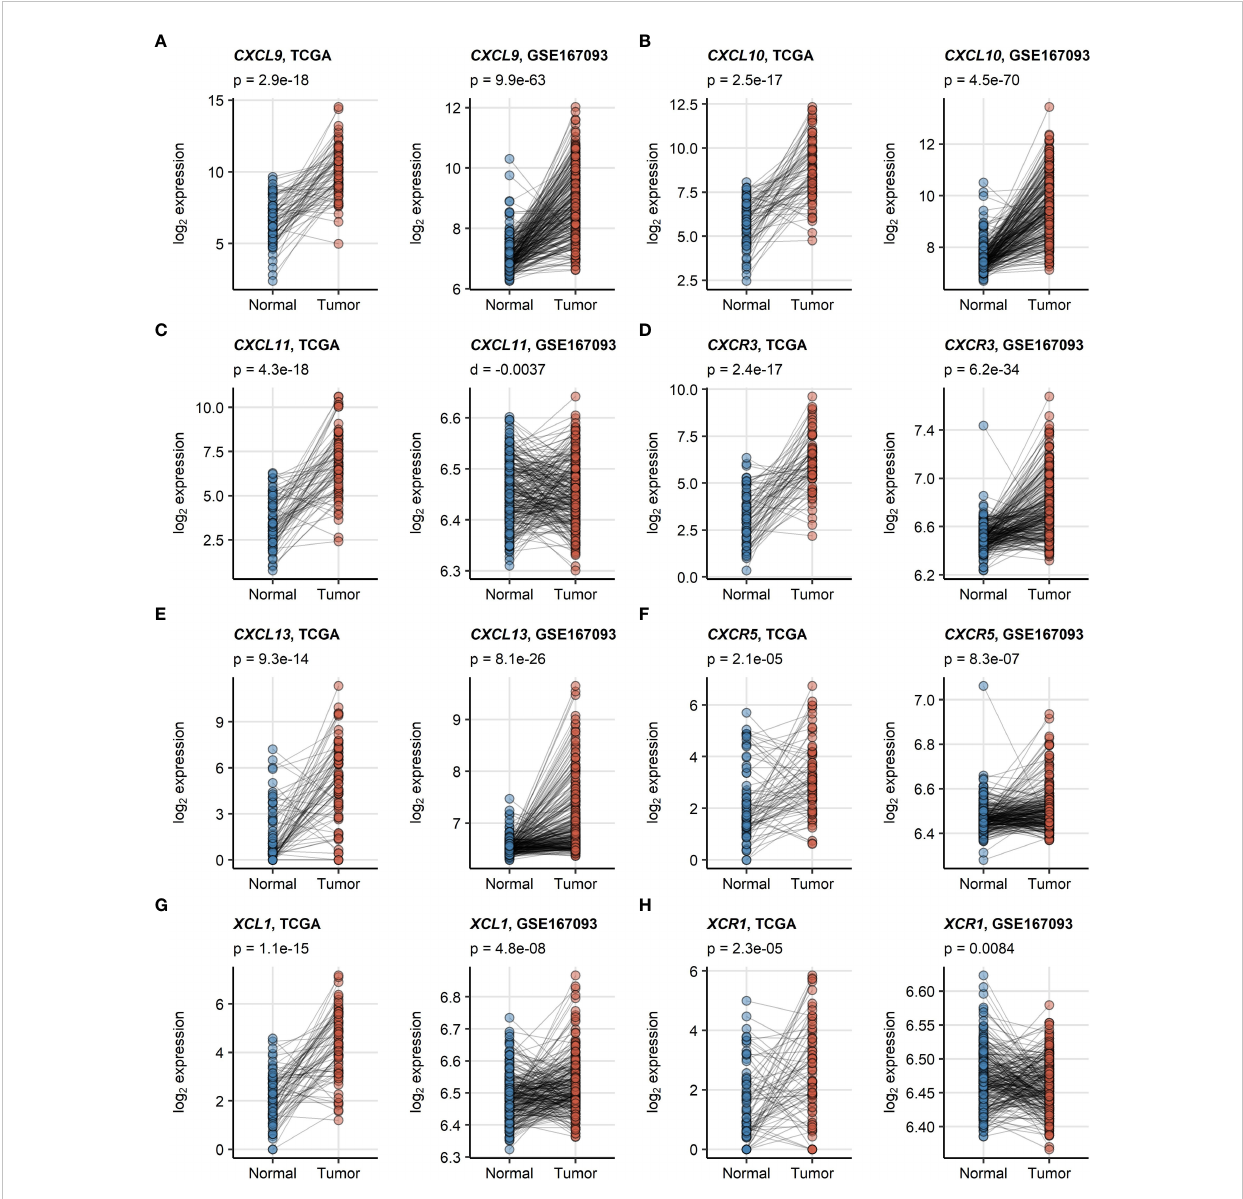
FIGURE 1 (A – H) Differences in expression of CXCL9/10/11 , CXCL13 , XCL1 and their cognate receptors between RCC and normal kidney tissue. Differences in expression of CXCL9/10/11, CXCR3, CXCL13, CXCR5, XCL1 and XCR1 between the RCC and normal kidney tissue were investigated in donor matched samples from the TCGA KIRC and GSE167093 cohorts by two-tailed paired T test. The results were corrected for multiple testing with false discovery rate (FDR) method. Points represent single samples, samples from the same tissue donors are connected with lines. P values are displayed in the plot captions. Numbers of tissue donors are indicated under the